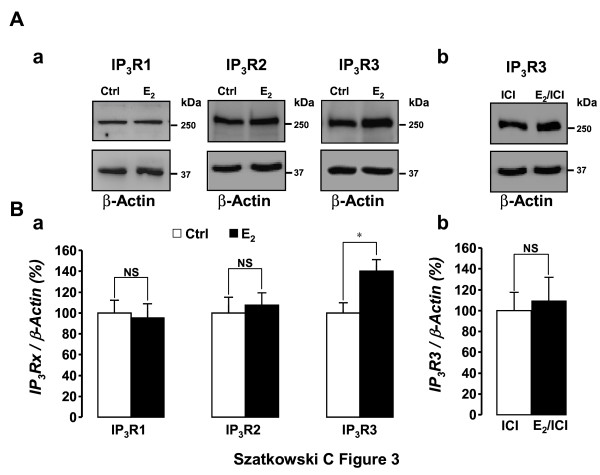
Expression of IP3Rs isoforms and their regulation by E2. (A) MCF-7 cells express the three IP3R isoforms. (a) Western blotting allowed the specific detection in MCF-7 microsomes (50 μg proteins/lane) of IP3R1, IP3R2 and IP3R3. Representative blots for 7 to 8 independent experiments are shown. Whereas E2 had no effect on the expression level of IP3R1 (left panel) and IP3R2 (middle panel), E2 increased the expression of IP3R3 (right panel, P < 0.05). This effect of E2 involves an estrogen receptor-dependent intracellular pathway since it was antagonized by the specific anti-estrogen ICI-182,780 (1 μM, b). (B) Statistical analysis of the effect of E2 on the expression level of the 3 types of IP3Rs (a) and of the inhibitory effect of ICI-182,780 on E2-induced stimulation of IP3R3 expression (b). In the presence or absence of ICI-182,780, the expression level of IP3R3 is not significantly different (113.4 ± 21.9 vs. 100.0 ± 18.2% in control conditions, n = 6).